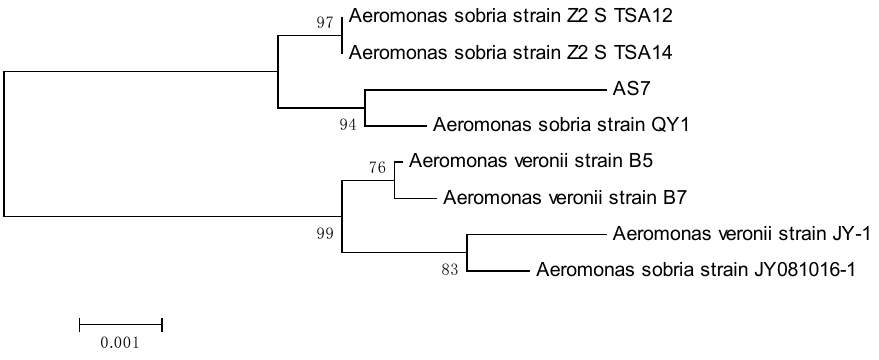
Figure 1. The phylogenetic relationships of strain AS7 and other Aeromona .